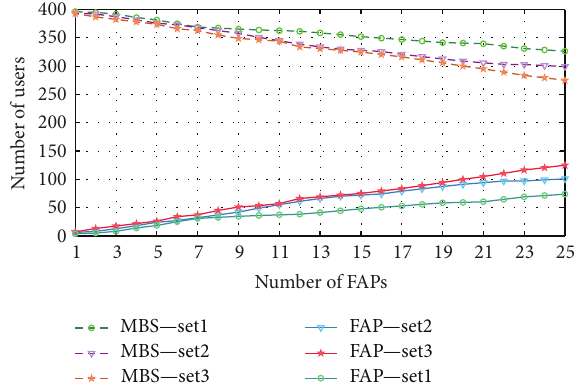
Figure 6: Users served by FAPs and